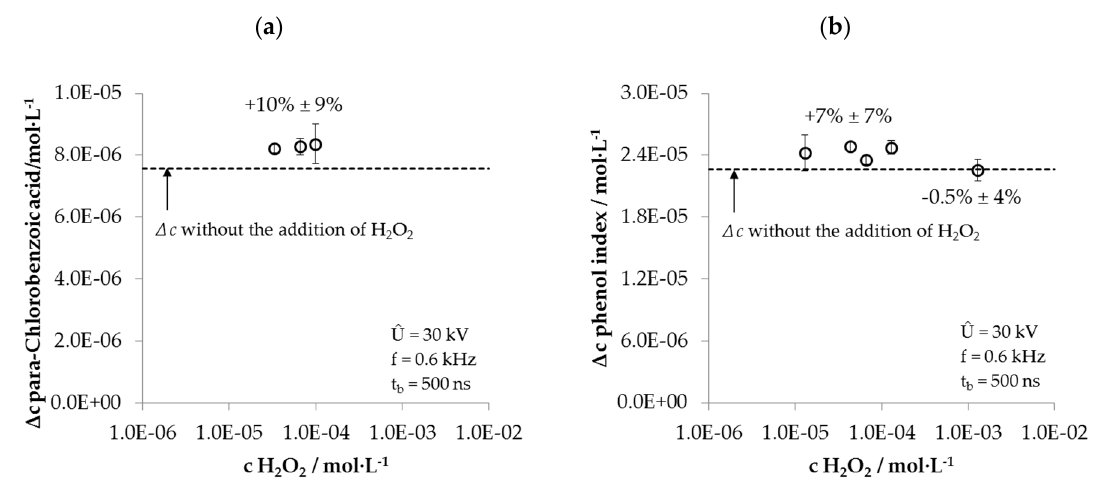
Figure 6. Decrease of ( a ) para-Chlorobenzoic acid and ( b ) phenol index concentration ( Δ c ) depending on H 2 O 2 concentration in the process on H 2 O 2 concentration in the process water.